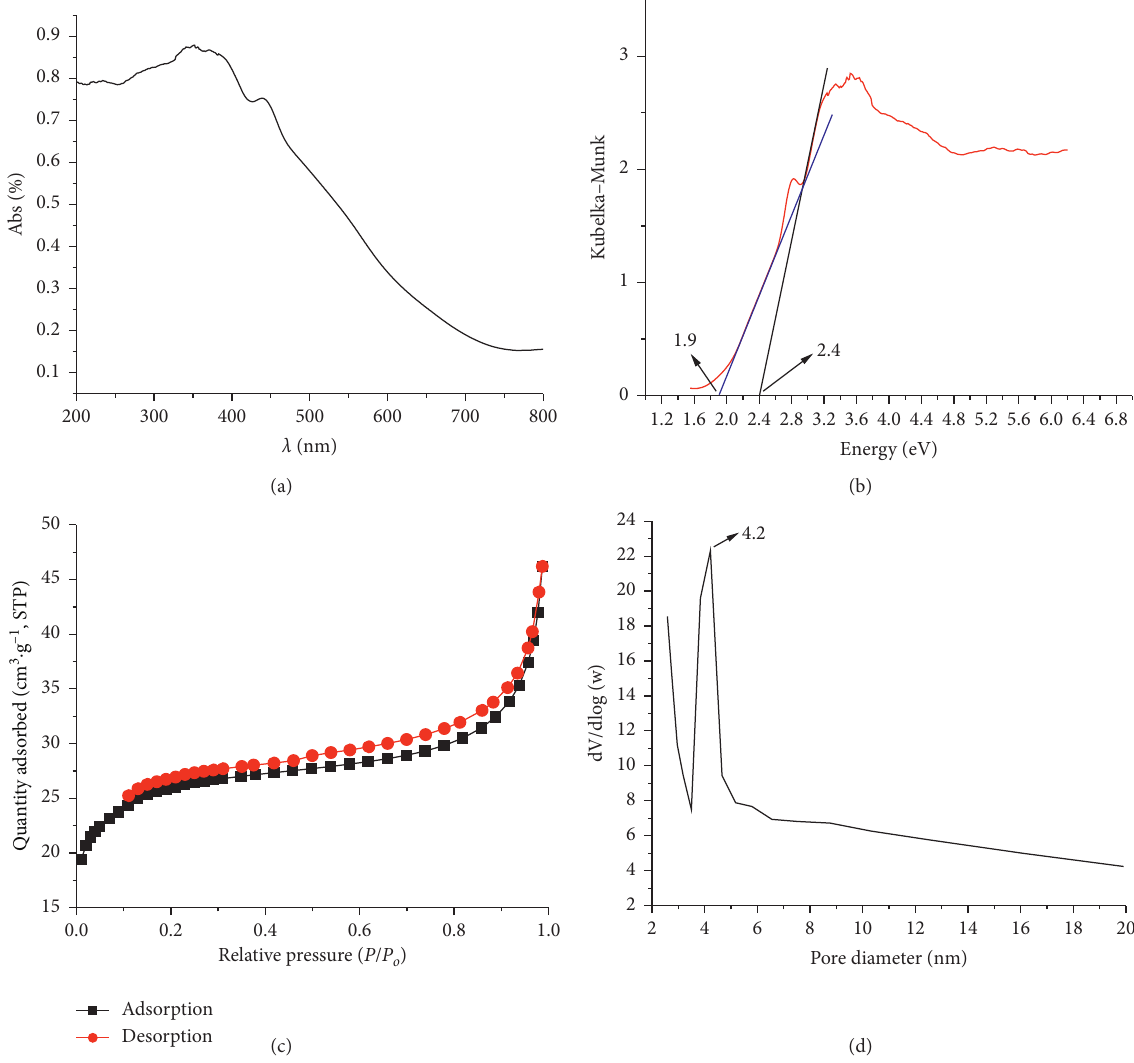
Figure 5: (a) UV-Vis diffuse reflectance spectrum, (b) the plot of Kubelka–Munk function versus the energy of absorbed light, (c) nitrogen adsorption-desorption isotherms, and (d) pore size distribution of the MIL-53 sample (FeCl 3 /TA molar ratio � 1: 2 at the hydrothermal temperature 150 °